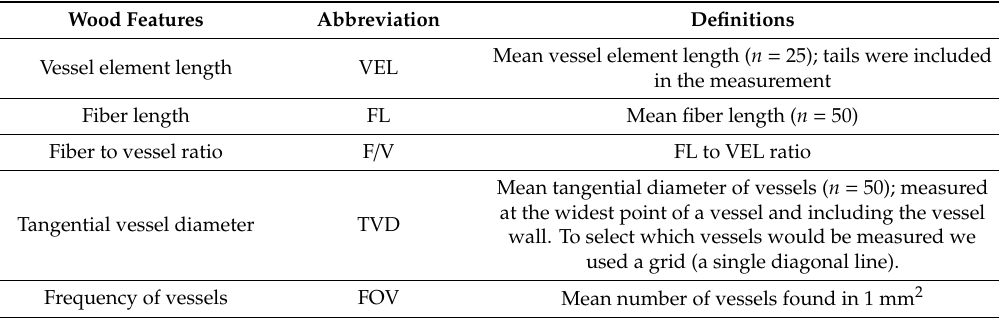
Table 1. Definitions of and number of measured and calculated